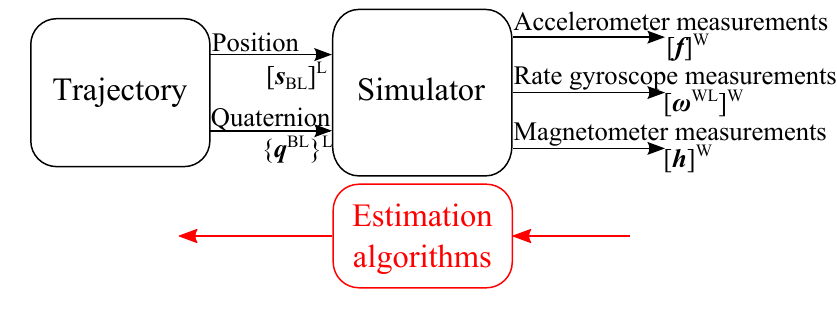
Figure 1. Simulator